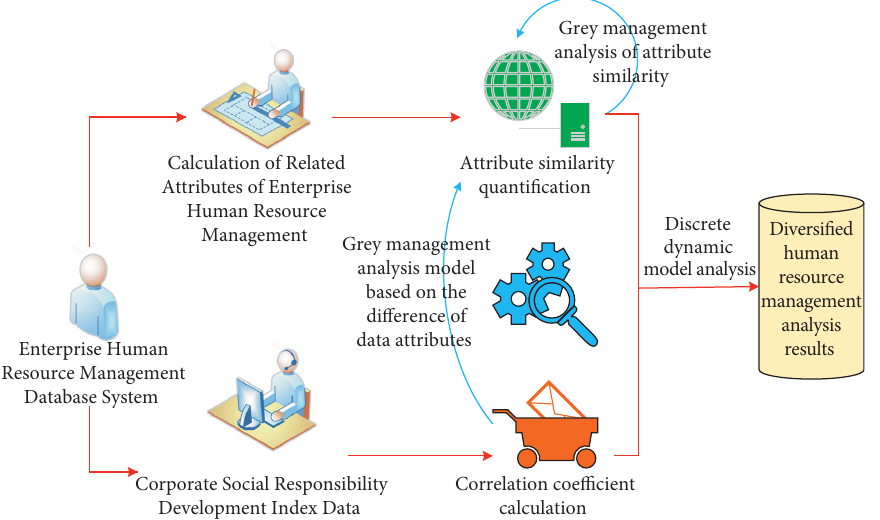
Figure 2: The dynamic analytical process of the grey relational model of enterprise human resource management.